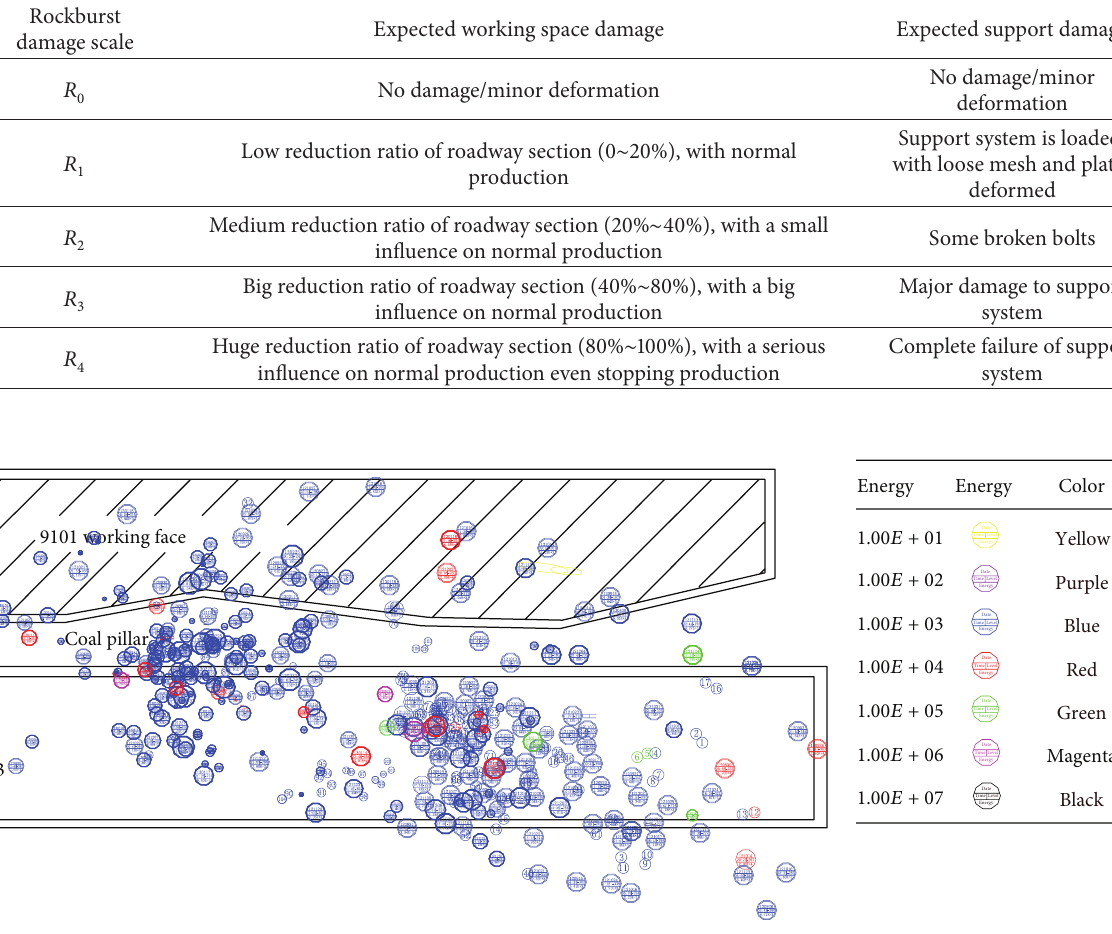
Figure 6: Diagram of